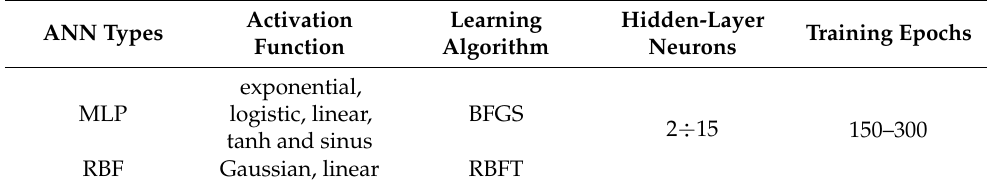
Table 3. Results of mathematical modelling of the Sa parameter as a function of the feed rate for different values of the depth of cut (regression functions y = Sa(f z ); f z = x with the coefficient of de- Table 2. Artificial neural network learning parameters. termination R 2 ).